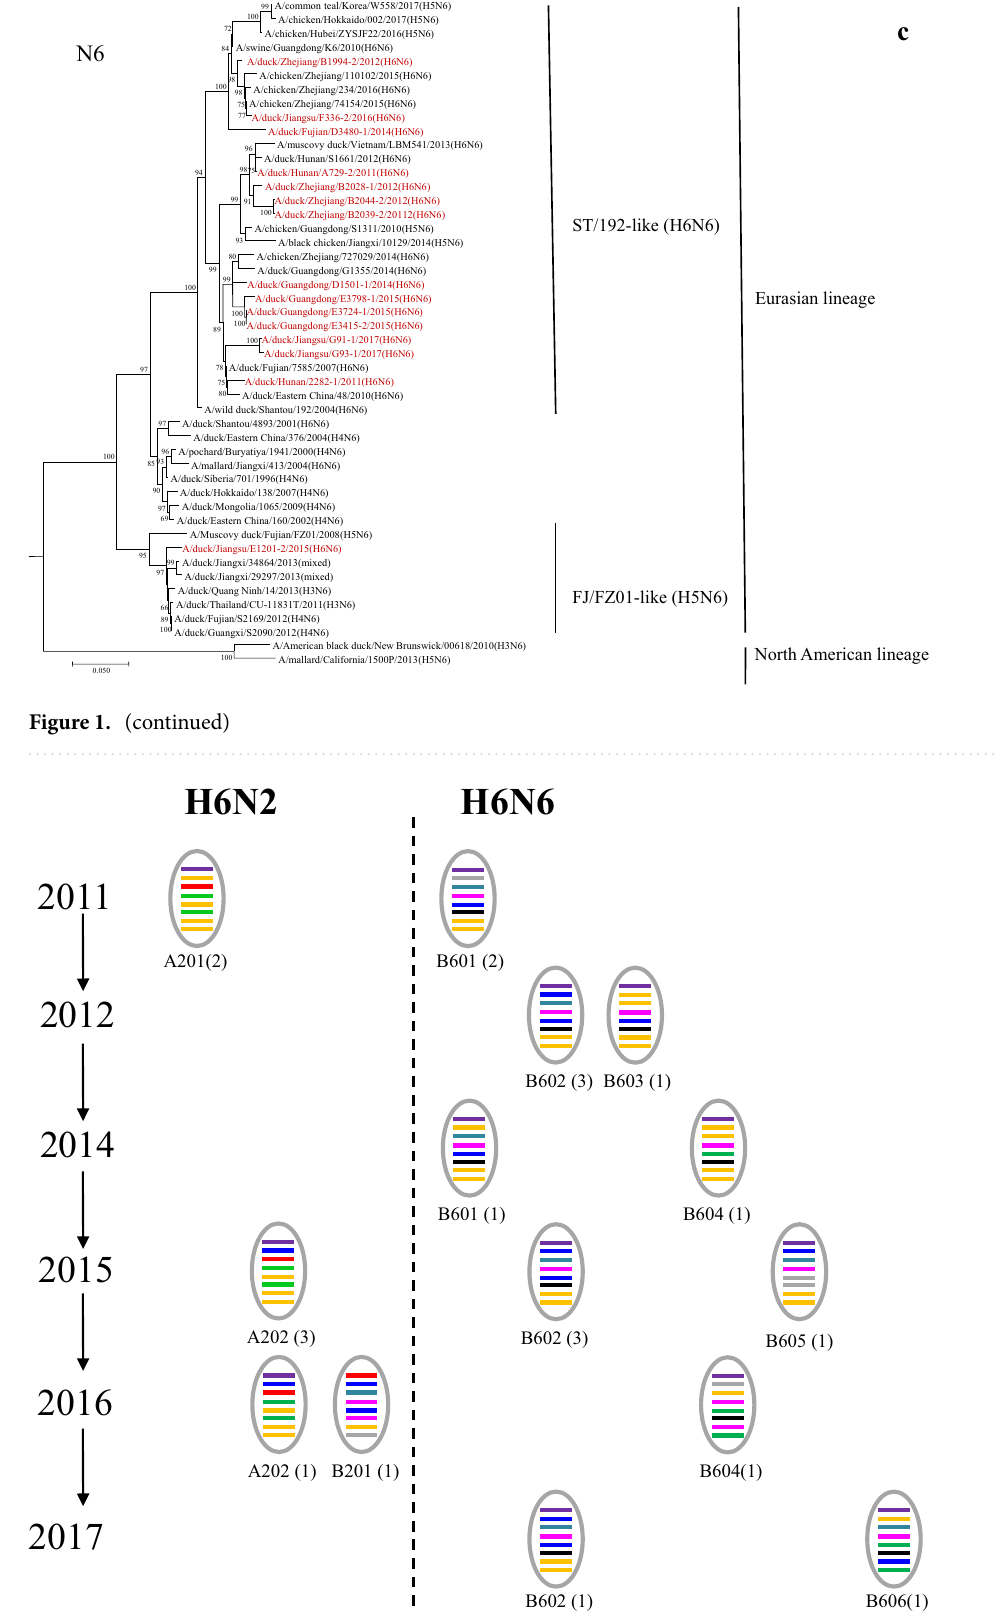
Figure 2. Genotypes of H6 AIVs isolated from 2011 to 2017 in Southern China. The genotypes of H6 influenza viruses were determined by the clades of each of their gene segments on the phylogenetic